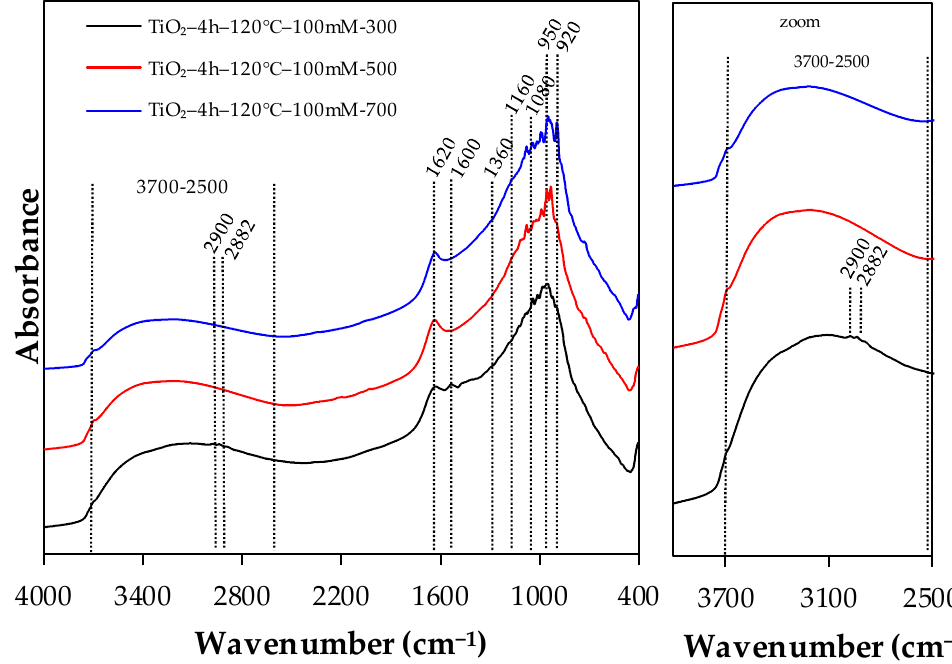
Figure 1. DRIFT spectra of APTES-modified TiO 2 with zoom in wavenumber in the range of 2500–4000 cm − 1.